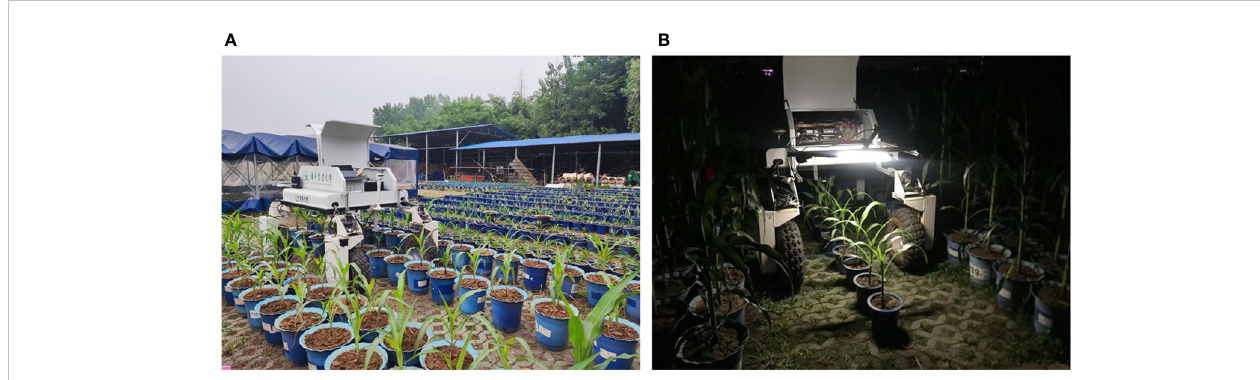
FIGURE 7 Scene of data acquisition during three periods of a day (A) Data acquisition in the day time (B) Data acquisition at night.